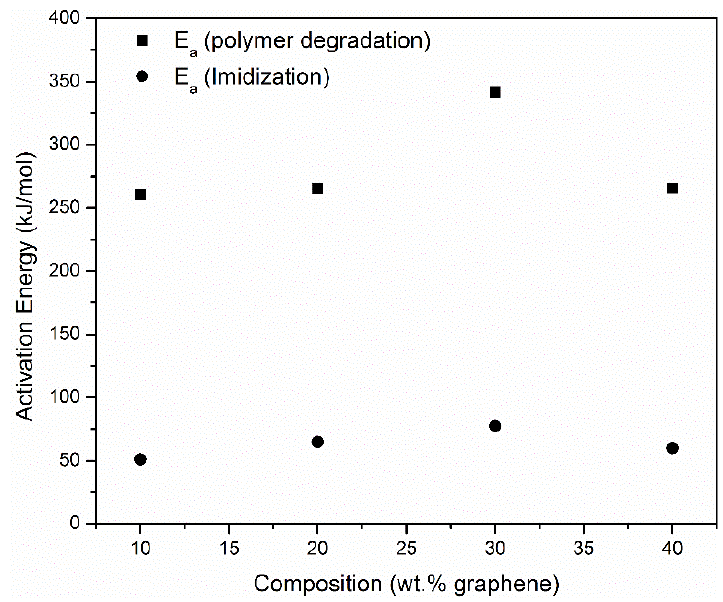
Figure 13. Activation energy of imidization and polymer degradation as a function of composition of graphene in the nanocomposites.